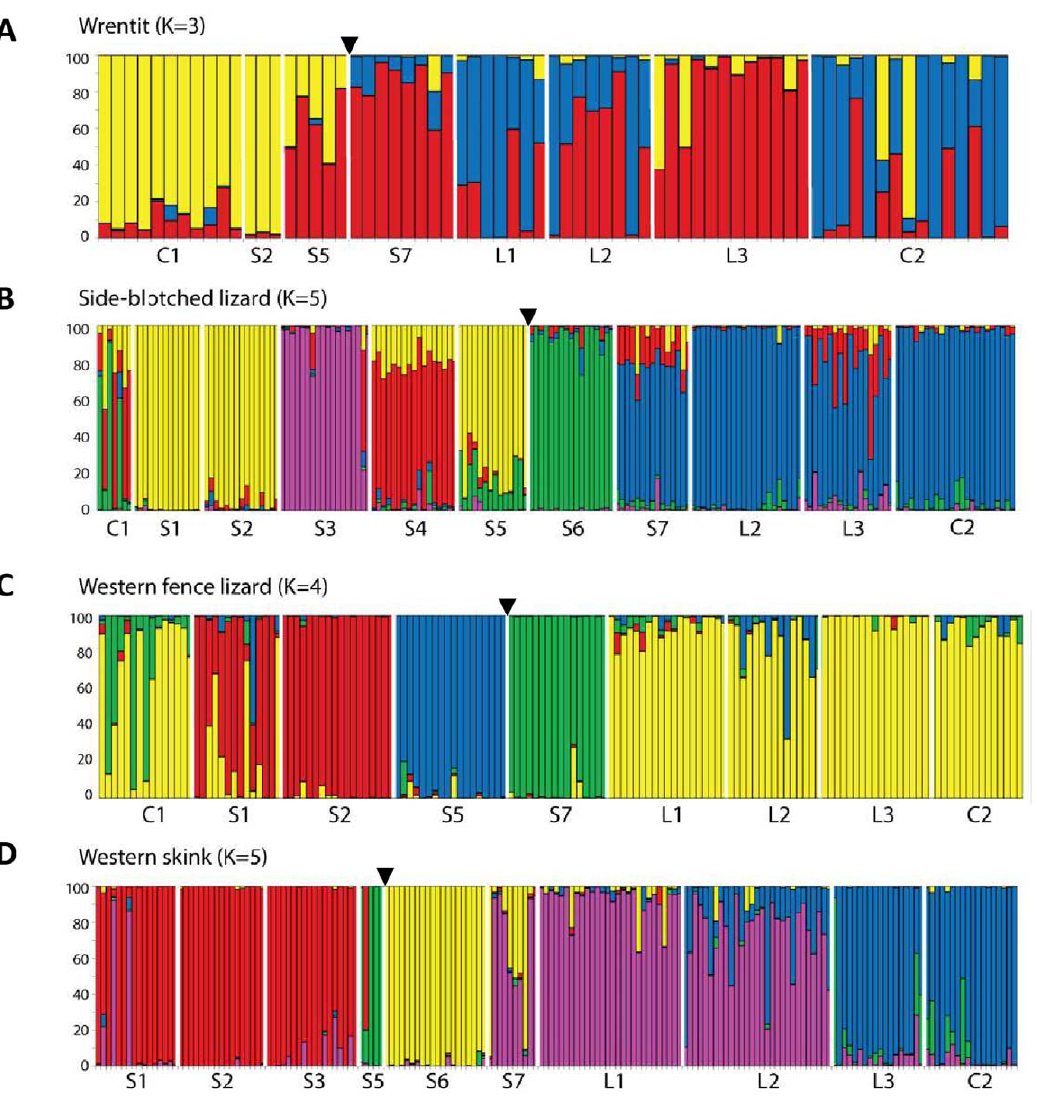
Figure 2. Genetic clustering analysis reveals the most likely K. Each column represents one individual and colors correspond to the percentage of assignment to each cluster. Patch names (Fig. 1a) are on the X-axis organized from west (left) to east (right). A black triangle indicates the location of the 23 freeway.